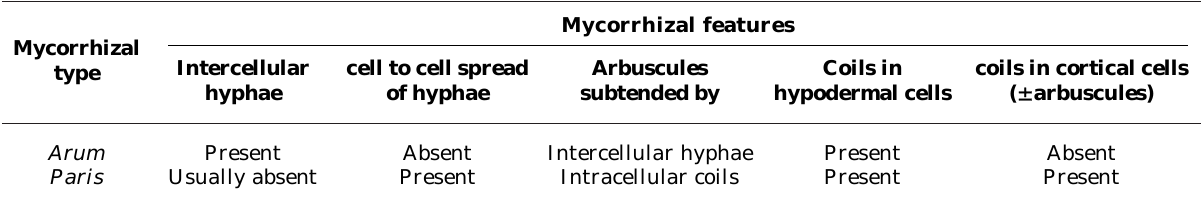
Table 1. Features of colonization in plant species with Arum - and Paris -type patterns of fungal development